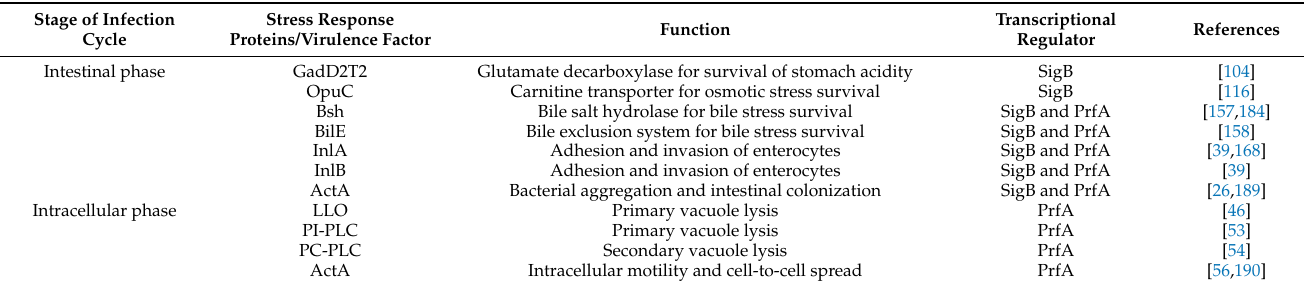
Table 1. Stress response proteins and virulence factors expressed by L. monocytogenes at different stages of the infection